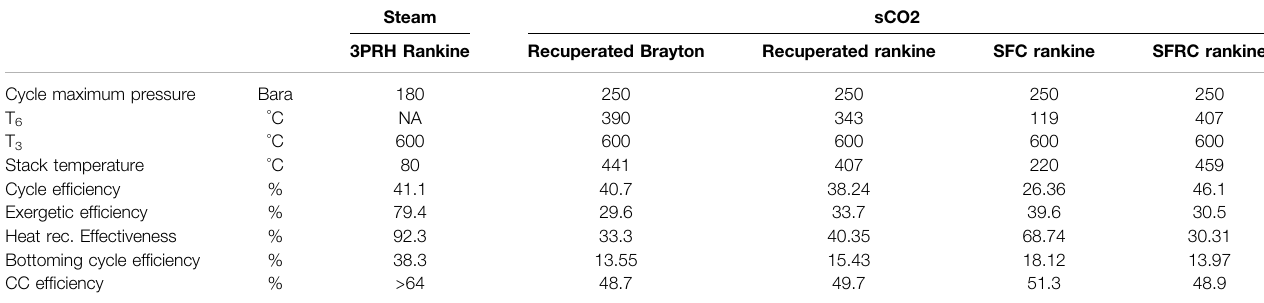
TABLE 10 | Steam and sCO 2 bottoming cycles with advanced gas turbines (SFC: Split-Flow Cascaded, SFRC: Split-Flow Recompression). Combined cycle ef fi ciency accounts for cycle pumps (including circ water pump) but no other aux load.